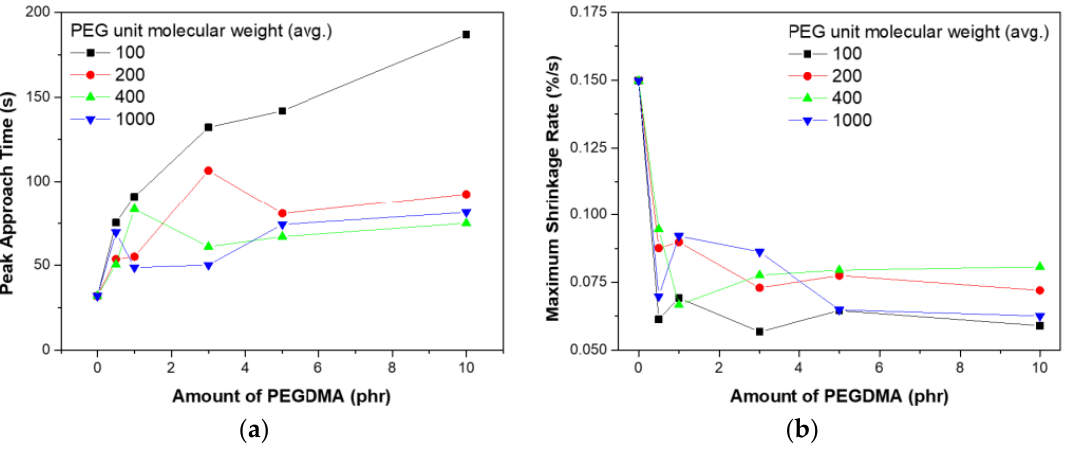
Figure 12. Shrinkage rates for different PEGDMA sizes: ( a ) peak approach time; ( b ) maximum shrinkage rate.